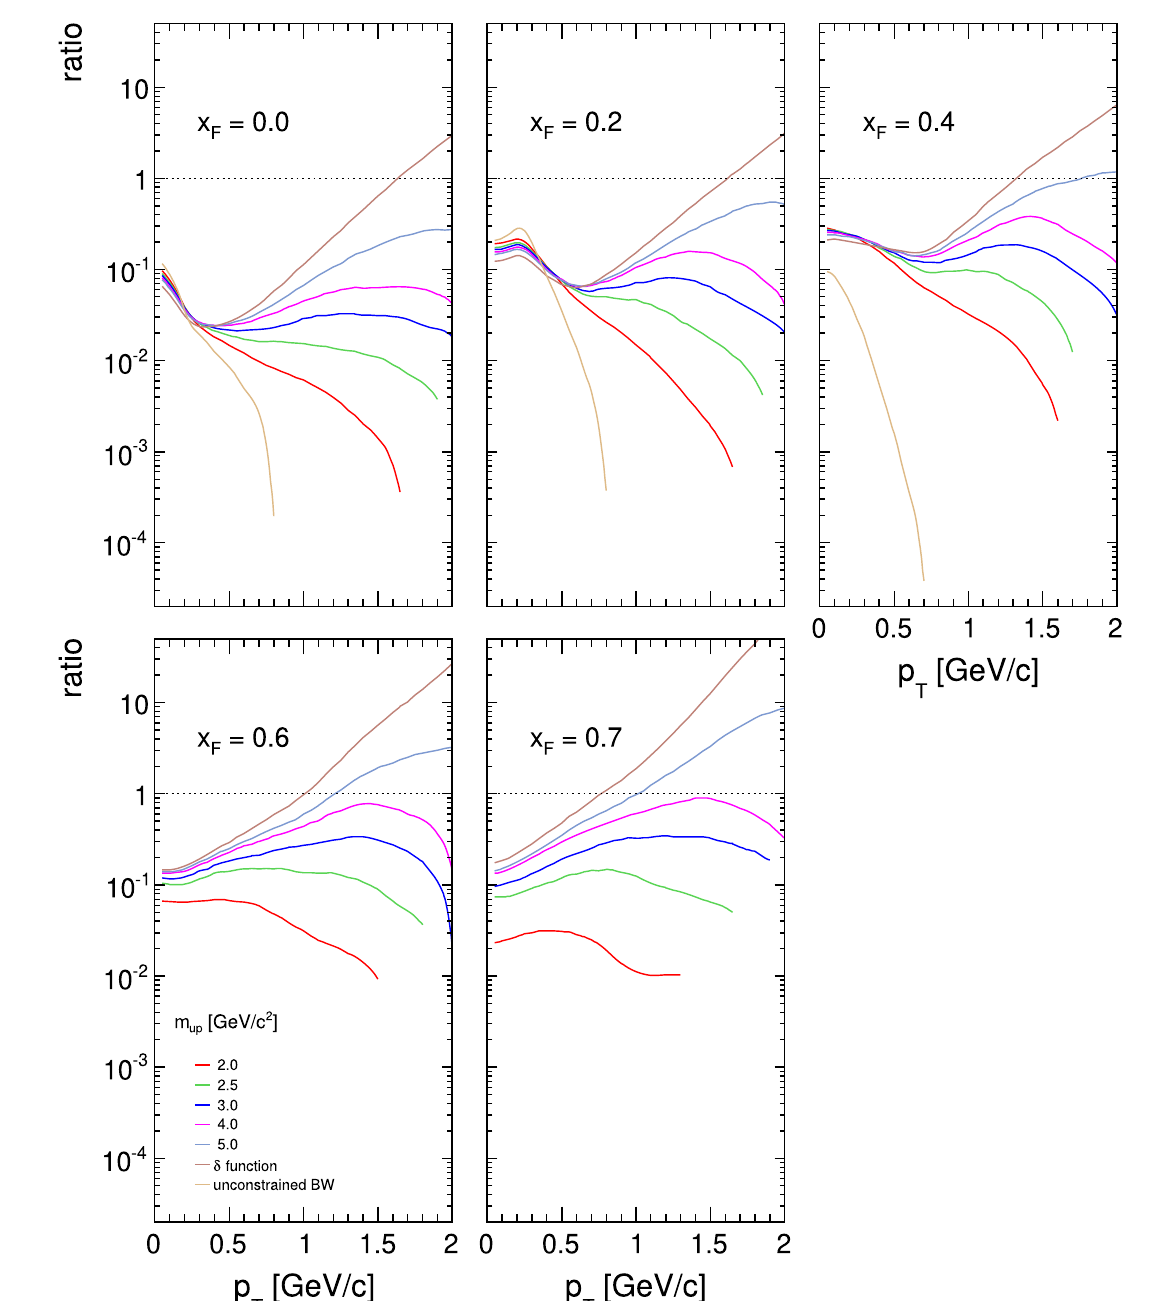
Fig. 170 Yield ratio R π + = f π + (Δ ++ )/ f incl (π + ) as a function of p T for x F between 0.0 and 0.7 and different mass cuts